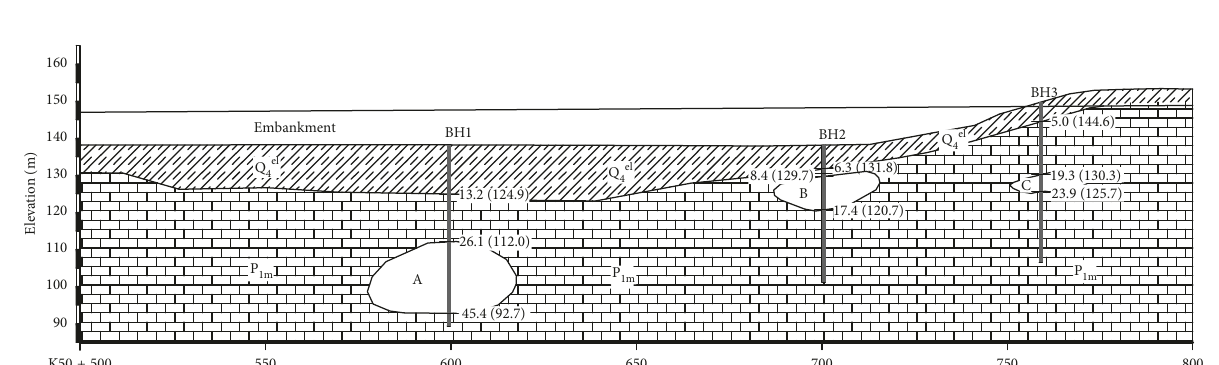
Figure 2: ERT profile.